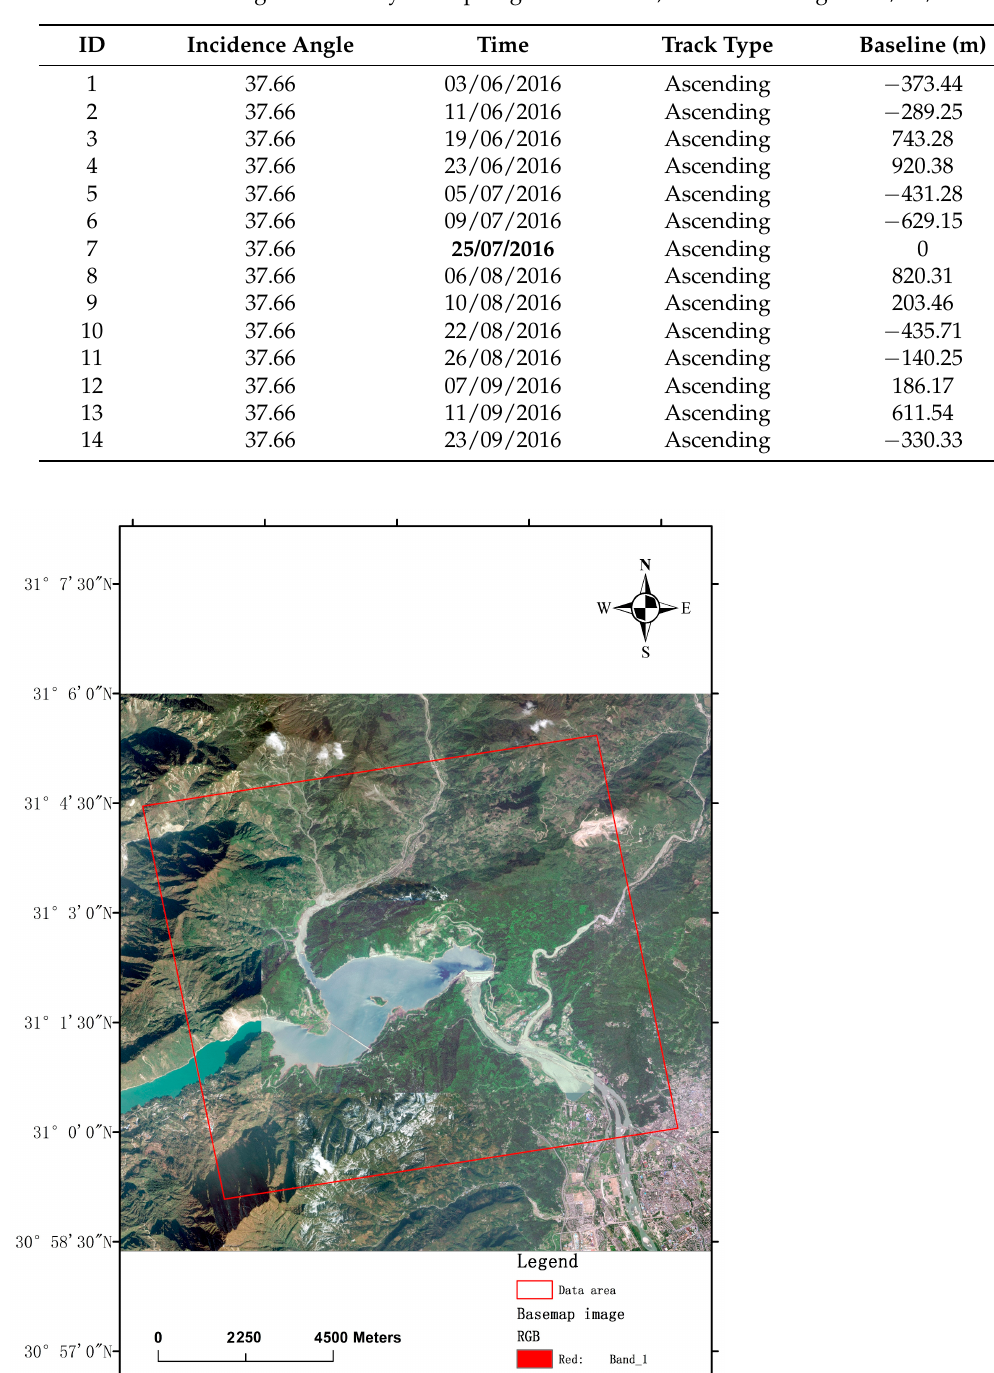
Table 1. The ascending COSMO-SkyMed Spotlight data stacks, the master image is 25/07/2016.